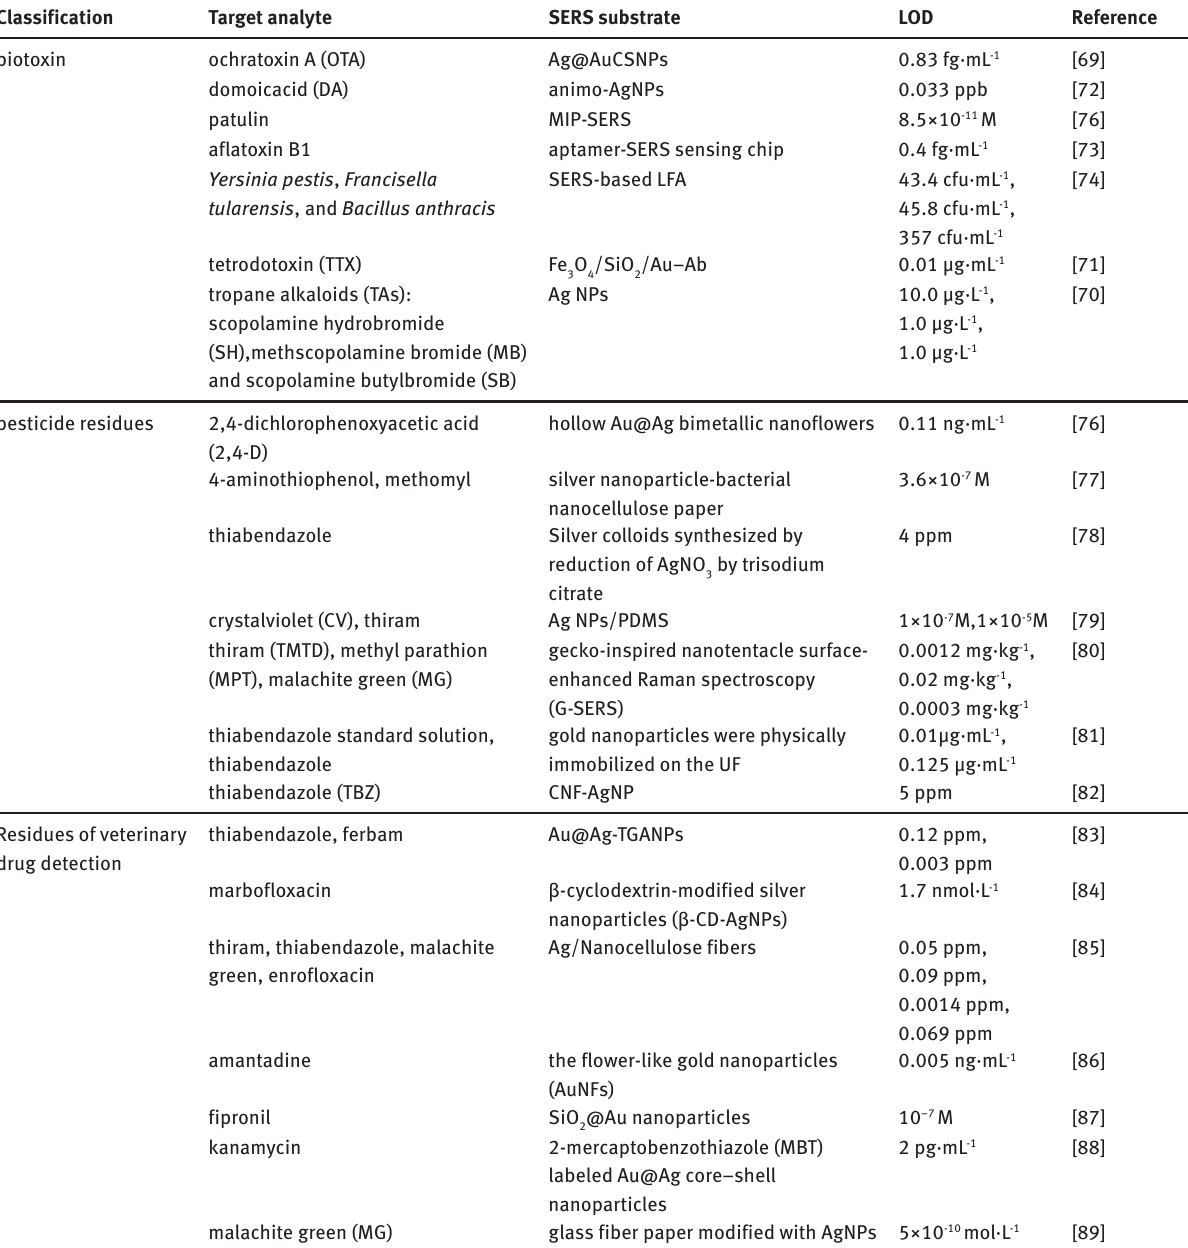
Table 1: ( continued ) Classification Target